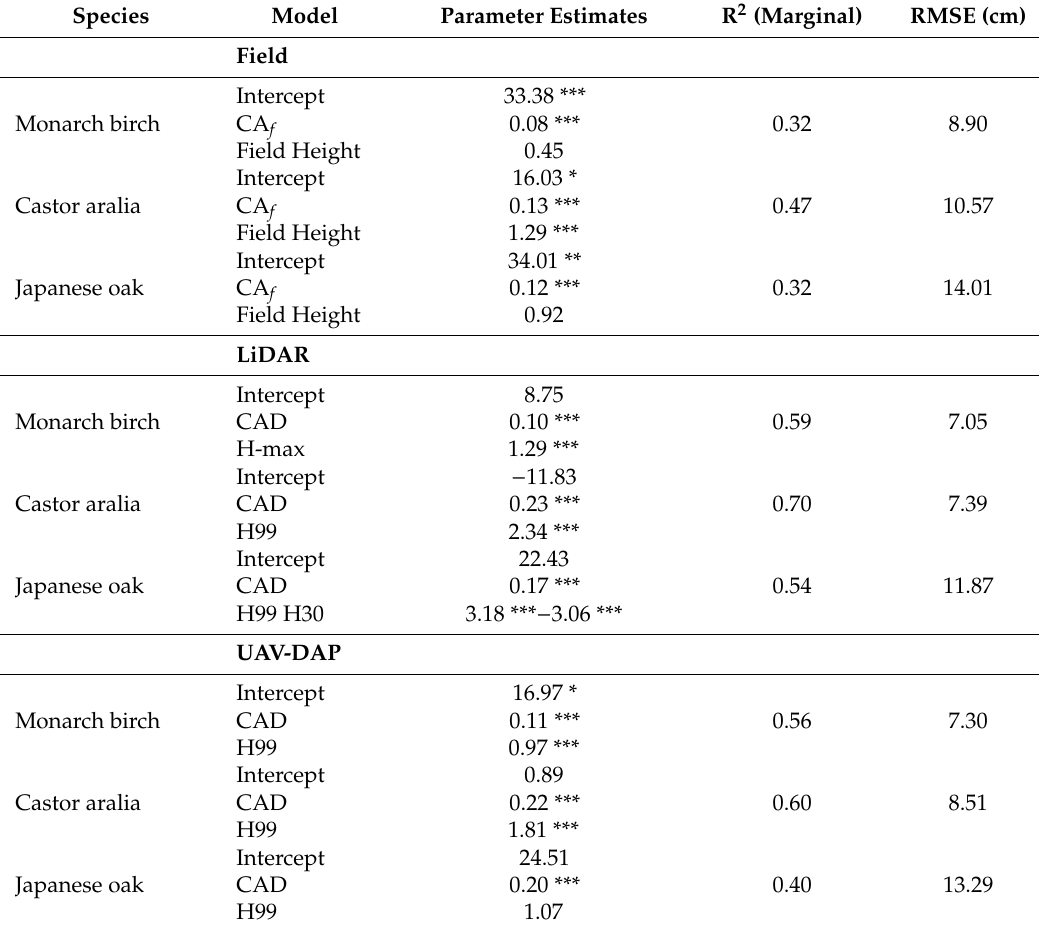
Table 7. DBH estimation